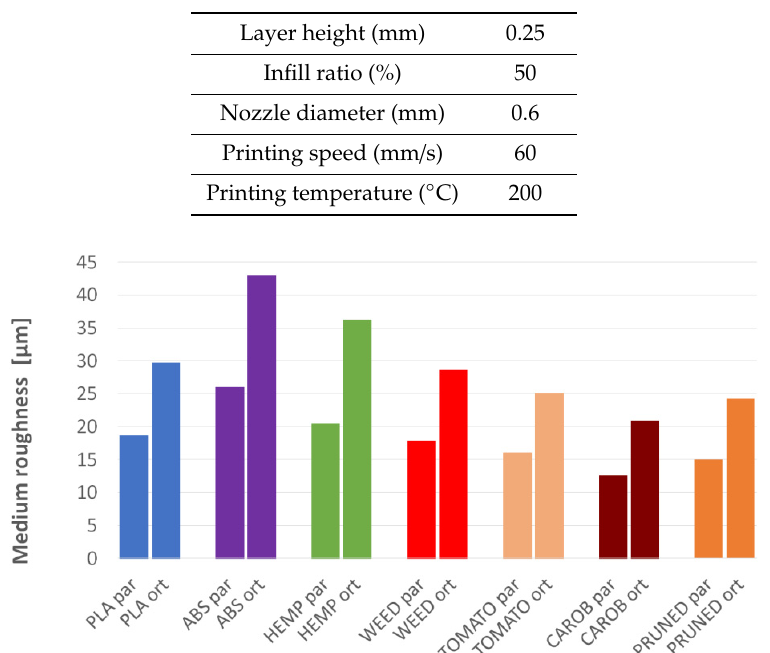
Figure 3. R a of new composites in comparison with pristine polylactic acid (PLA) and acrilonitrile-butadiene-stirene (ABS).